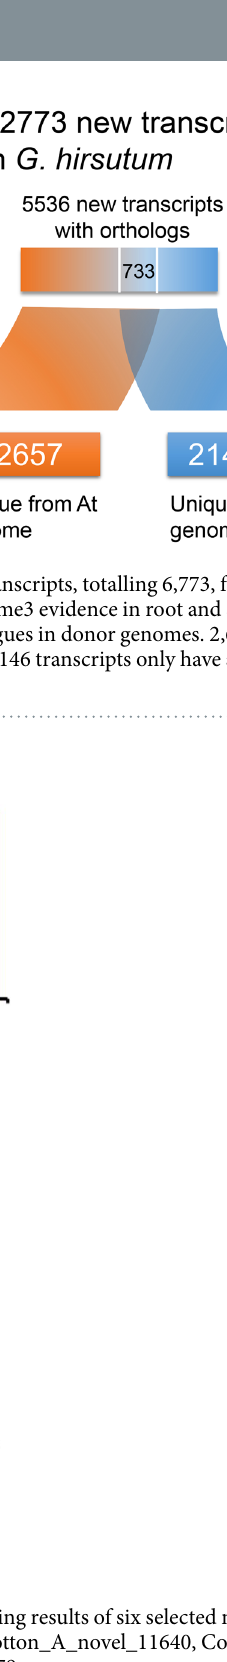
Modularized analysis of differential H3K4me3 modifications with changes in transcript levels. The pattern of H3K4me3 is conserved at the whole-genome level in cotton. However, there were also many active transcripts with differential histone modification.